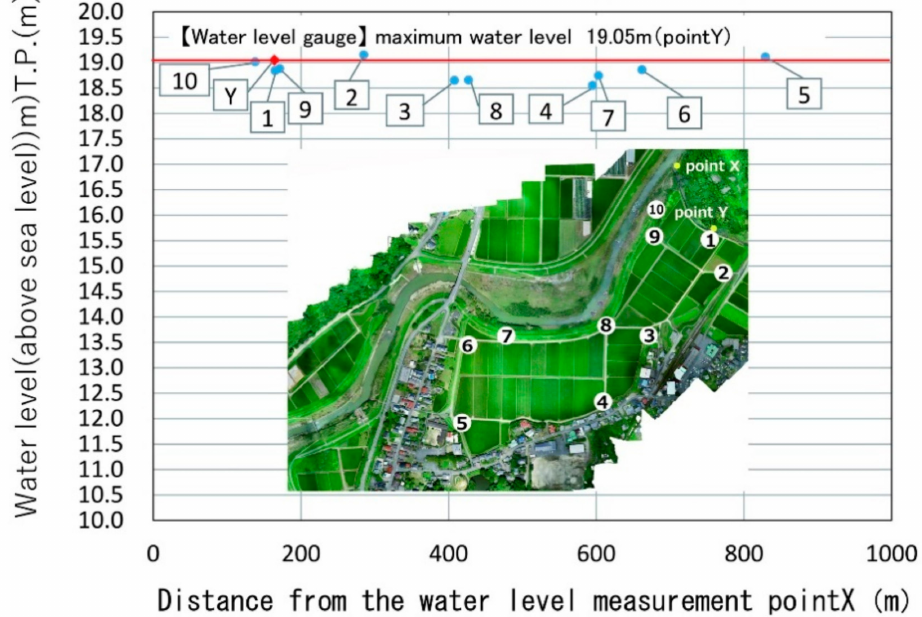
Figure 5. Water level and height of flood line. The points where the flood line is lower than the other points may underestimate the actual high-water levels because the values were determined based on evidence from plants, such as damage to the